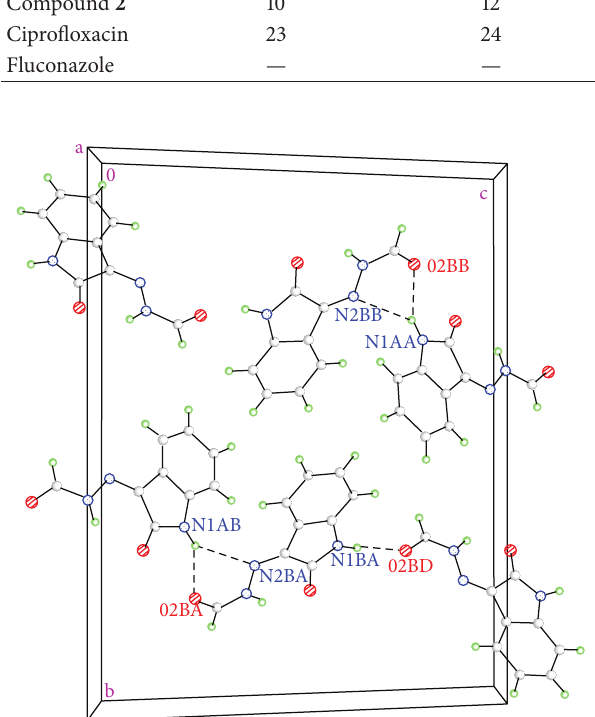
Figure 4: Portion of the crystal packing of compound 2 showing hydrogen bonds as dashed lines.